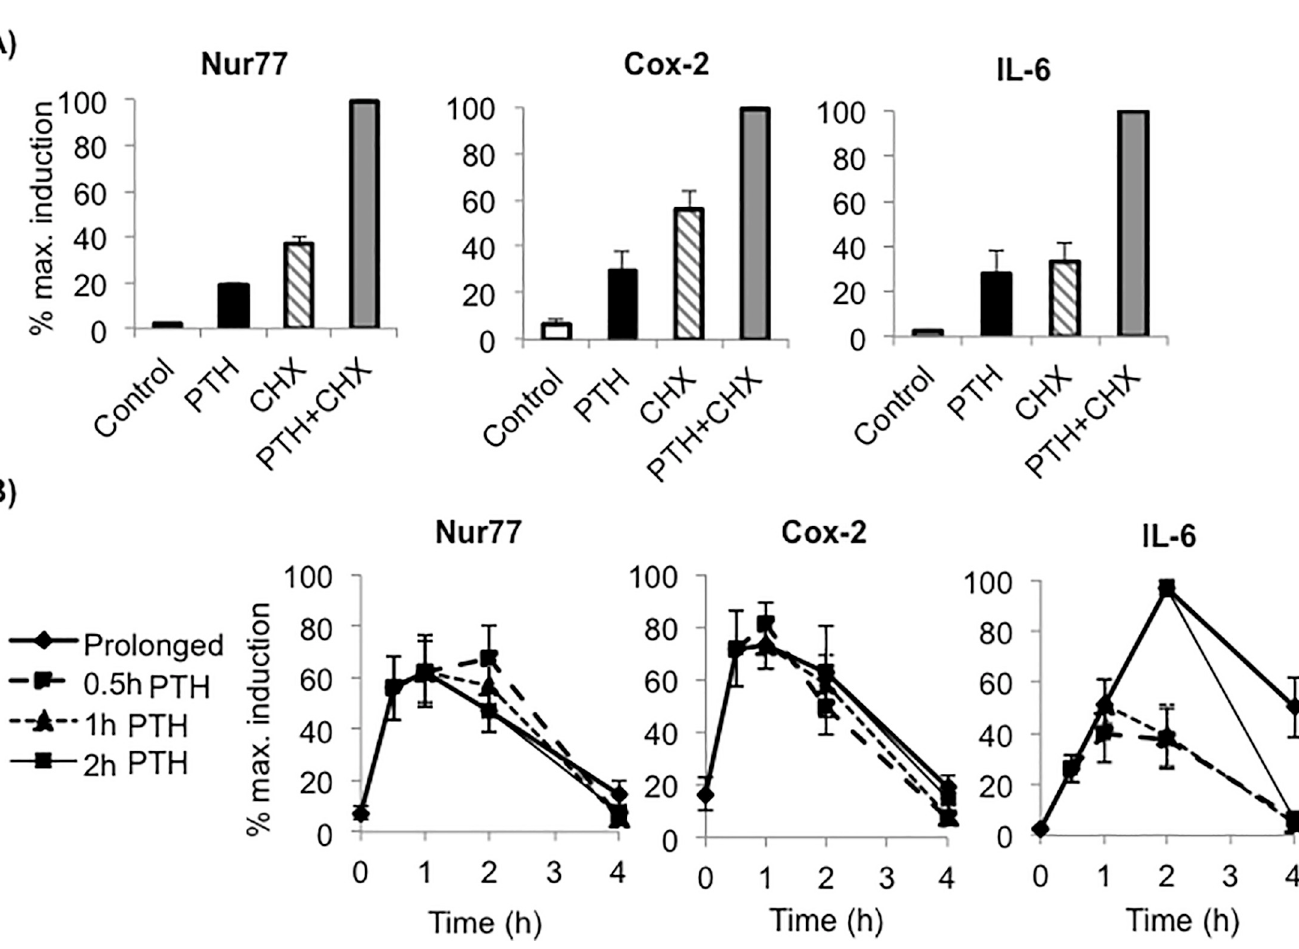
Fig 5. PTH-induced RANKL expression level was down-regulated by inhibition of actin polymerization inhibitor Cytochalasin D and ROCK inhibitor Y-27632 treatment. (A) PTH-induced changes in filamentous actin (f-actin) cytoskeleton arrangement in pOBs. For visualization of f-actin, cells were treated with either prolonged PTH (PTH) or brief PTH, stained with rhodamin-phalloidin and fixed with 4% formaldehyde to be examined under fluorescence microscopy. For brief PTH, cells were treated with PTH for one hour, changed into a PTH-free medium, and prepared for staining after 30 minutes (bottom left image) or one hour (bottom right image). (B) PTH-induced changes in the amount of active Rho in pOBs. Cells treated with PTH for the indicated period of time were prepared for Rho activation assay pulling-down active Rho, which was subsequently detected by immunoblot analysis using the anti-Rho antibody. Note that activation of Rho was rapidly induced by 15 minutes of PTH treatment. A representative immunoblot image from three independent experiments with similar results is shown. (C) qPCR analysis of Nurr1 (left) and RANKL (right) mRNA level in pOBs treated with 2 μ M actin polymerization inhibitor Cytochalasin D (CD) or 2 μ M ROCK inhibitor Y-27632 15 minutes prior to PTH treatment for indicated hours. Note that the maximum mRNA level of only RANKL, not Nurr1, was significantly down-regulated by CD as well as Y-27632 pre-treatment. Values were normalized by GAPDH and presented as a percentage of the maximum expression level (n = 5, mean ± SEM, � p < 0.05, �� p < 0.01). (D) The effect of ROCK inhibitor Y-27632 treatment on PTH-induced histone H4 acetylation near the transcription start sites of Nurr1 (left panels) and RANKL (right panels). pOBs pre-treated with 2 μ M ROCK inhibitor Y-27632 for 15 minutes and treated with 10 nM PTH for indicated hours. Cross-linked chromatins from POBs, treated with PTH for indicated hours, were immunoprecipitated with anti-acetylated Histone H4 antibody or without the antibody. Immunoprecipitated chromatins were reverse-cross-linked and subjected to PCR analysis using primers amplifying near the transcription start site of Nurr1 and RANKL (primer sequences indicated in S1 Table). PCR products were separated on 8% acrylamide gel. A representative image from three independent experiments with similar results is shown. Note that, for Nurr1 as well as RANKL, no significant changes in Histone H4 acetylation near the transcription start sites were observed with Y27632 pre-treatment. (E) The effect of MEK inhibitor U0126 treatment on PTH-induced Rho activation. pOBs, pre- treated with 10 μ M MEK inhibitor U0126 15 minutes prior to PTH, were prepared for Rho activation assay and subsequent immunoblot analysis with anti-Rho. No significant increase in PTH-induced Rho activation was noted in cells pre-treated with U0126. Representative immunoblot images from three independent experiments with similar results are shown.